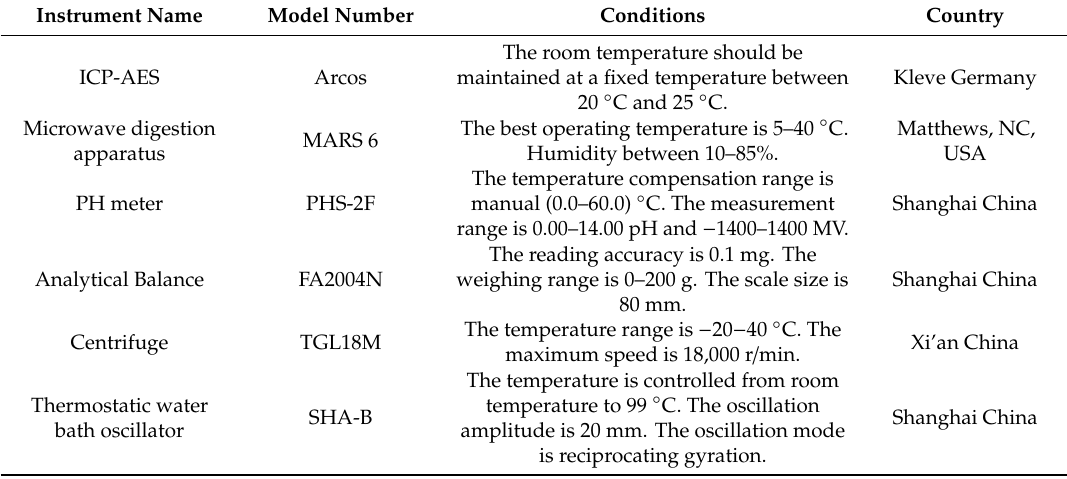
Table 1. The main equipment used.